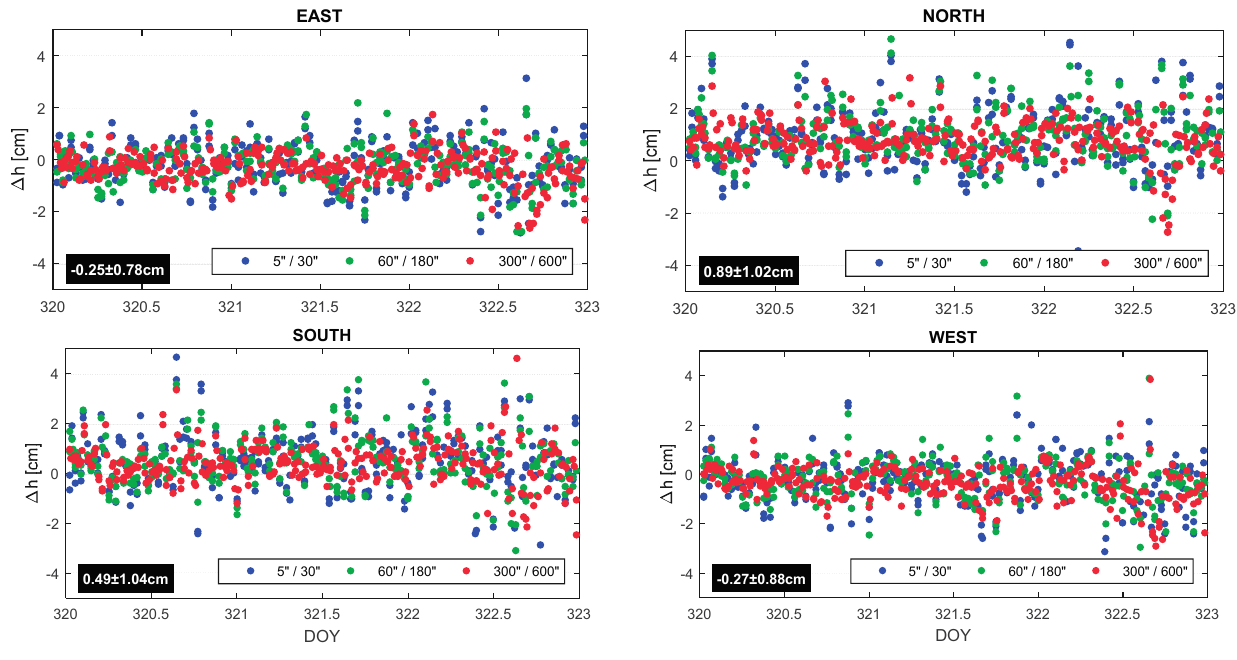
Figure 12. Ellipsoidal height errors plotted for all intervals.